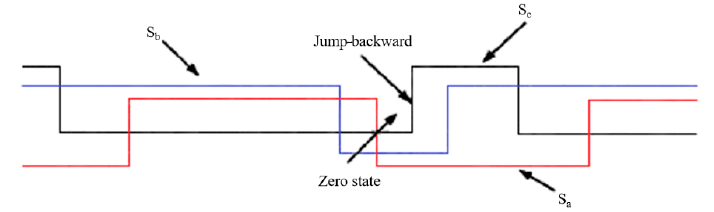
Figure 24. Schematic diagram of SVPWM jump-backward control strategy.